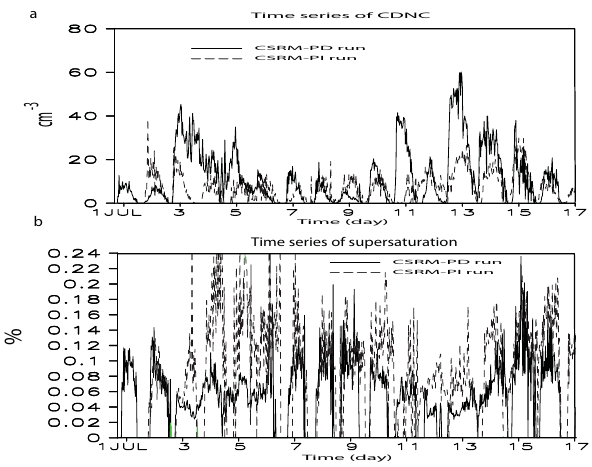
Fig. 10. Time series of conditionally averaged (a) CDNC (cm − 3 ) and (b) supersaturation (%) over areas where the condensation rate > 0 for the CSRM-PD run and the CSRM-PI run.